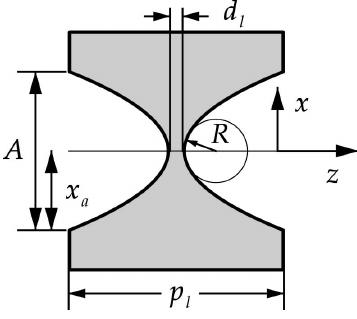
Figure 1 One element of the PCRL and its